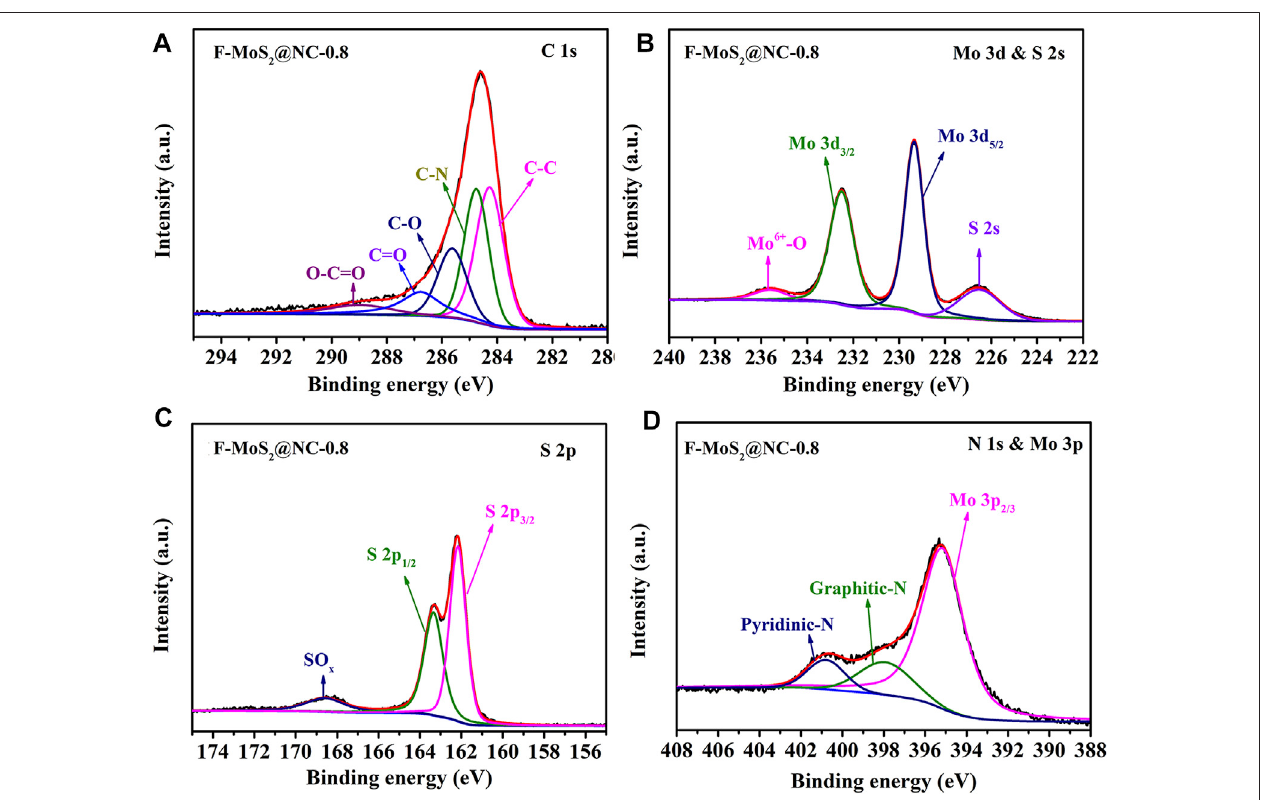
FIGURE 3 | High deconvolution of the XPS (A) C 1s, (B) Mo 3 days and S 2s, (C) S 2p and (D) N 1S and Mo 3p of F-MoS2@NC-0.8